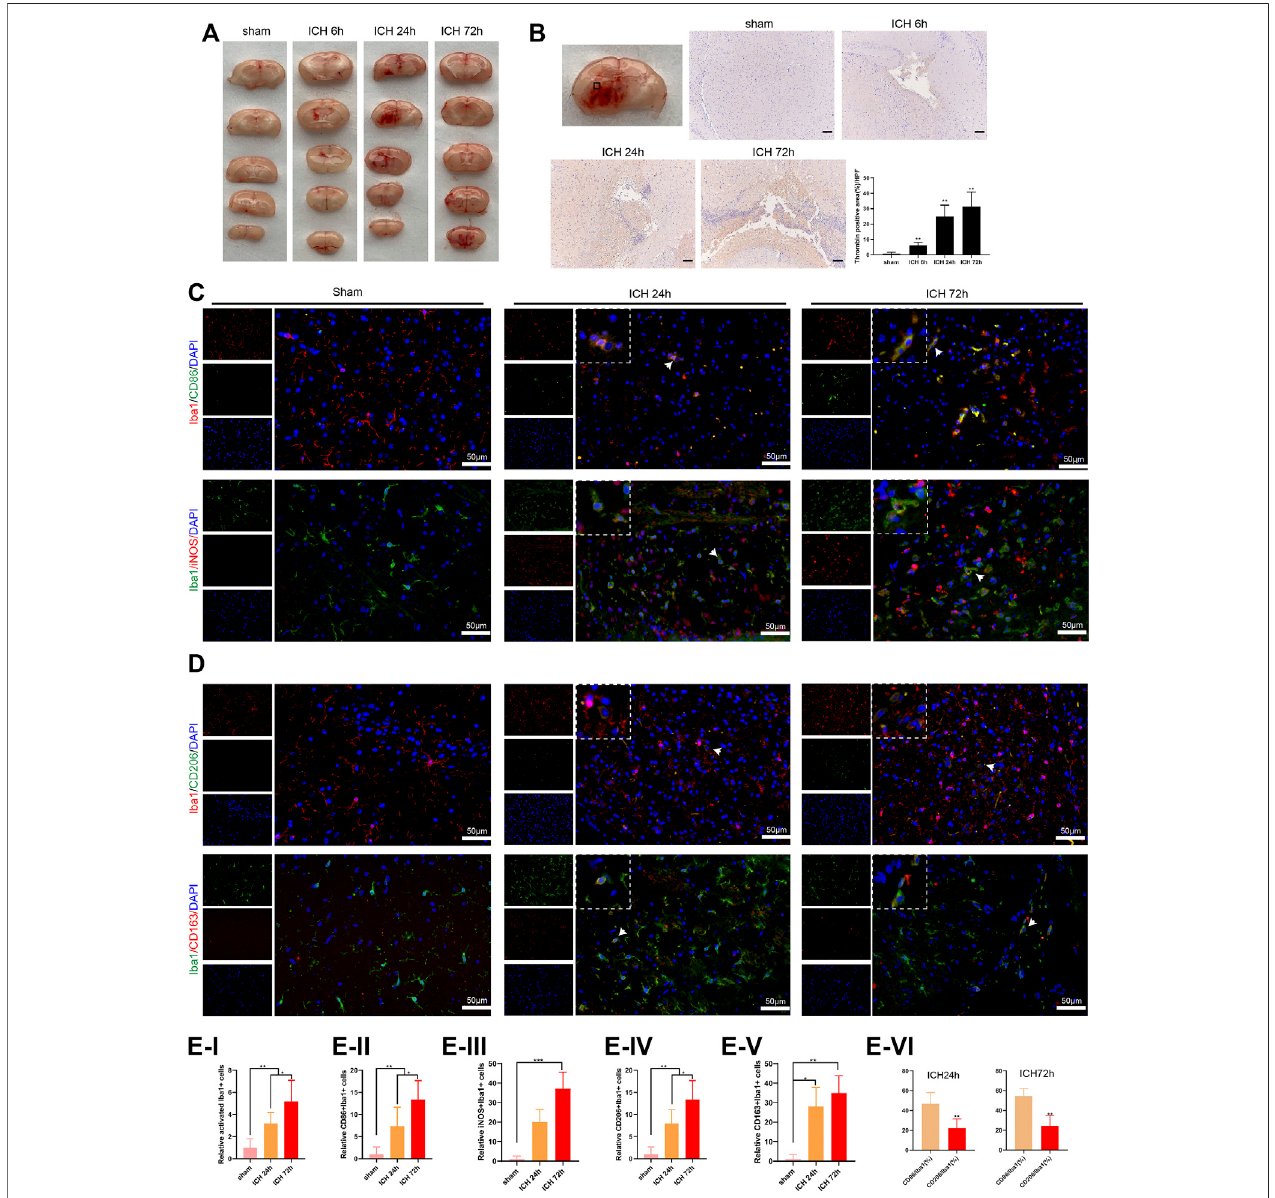
FIGURE 1 | Activation ofmicroglia in the injured area of mice with acute intracerebral hemorrhage. (A) Coronal section ofhematoma to observethe bleeding in the brain of mice, n (cid:2) 6 (Scale bar (cid:2) 100 μ m). (B) Detection of thrombin by immunohistochemistry assay, n (cid:2) 6. (C – E) Immuno fl uorescence analysis was conducted to observethe activation ofmouse microglia,including therelative activated Iba1+ cells, relative CD86+/Iba1+ cells, iNOS+/Iba1+ cells, CD206+/Iba1+ cells and CD163+/ Iba1+cells,n (cid:2) 6(Scalebar (cid:2) 50 μ m).* p < 0.05vs.shamorICH24 h** p < 0.01vs.shamorCD86/Iba1(%).*** p < 0.001vs.sham.ICH,intracerebralhemorrhage.